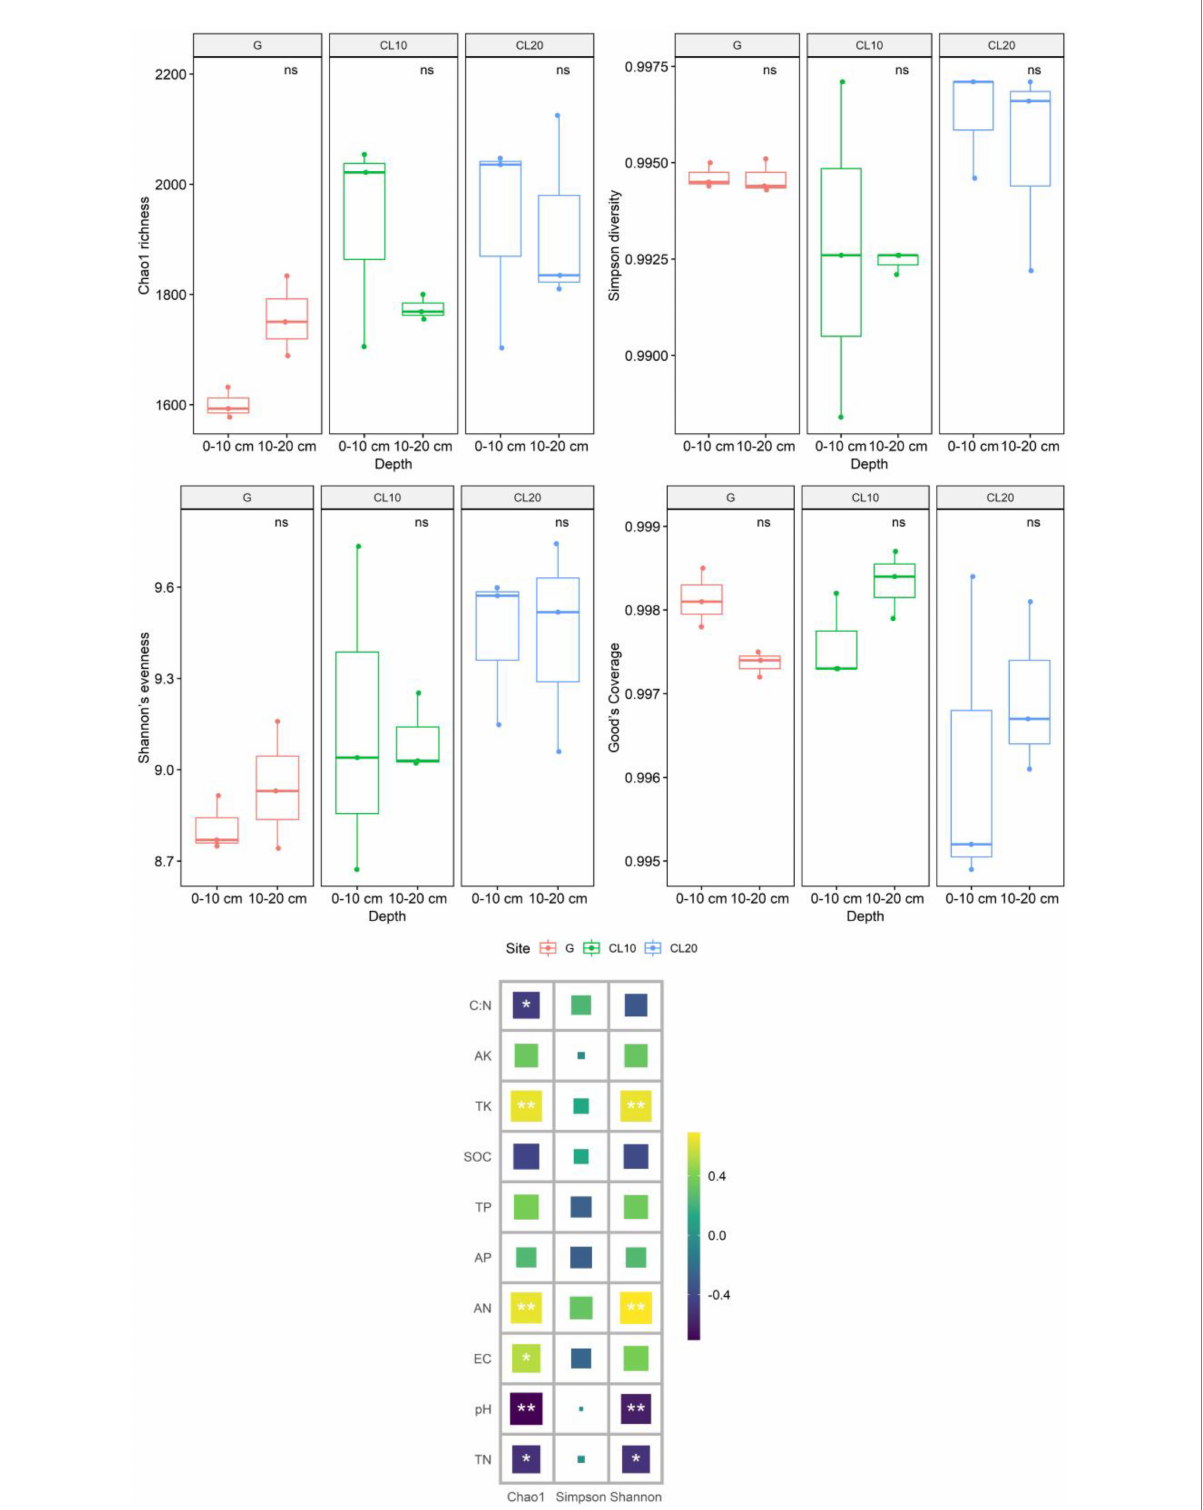
FIGURE 2 Effects of different land use types, depths, cultivated land years and soil properties on soil bacterial community diversity[Values are the means ± SEs ( n = 3). Different letters represent significant differences between the means ( p <